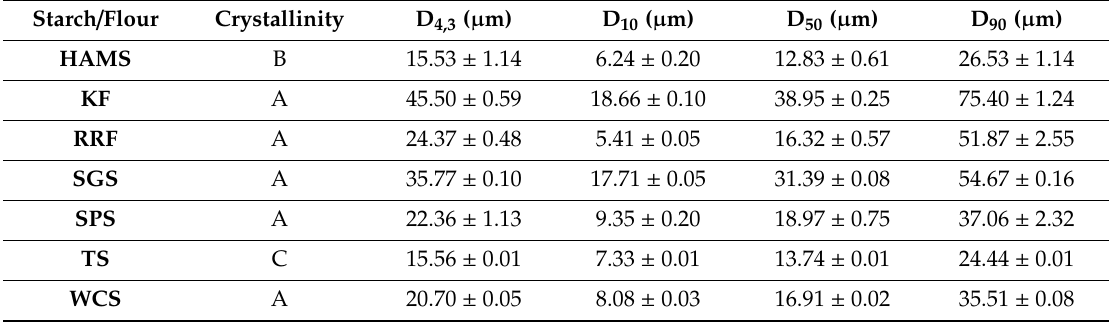
Table 2. The morphological properties of the starch and flours (data are means ± standard deviations). Starch / Flour